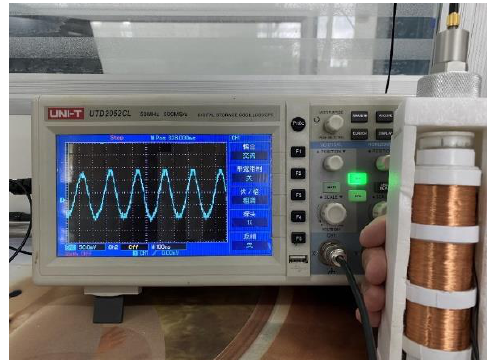
Figure 11. Picture of the hand-shaking test.